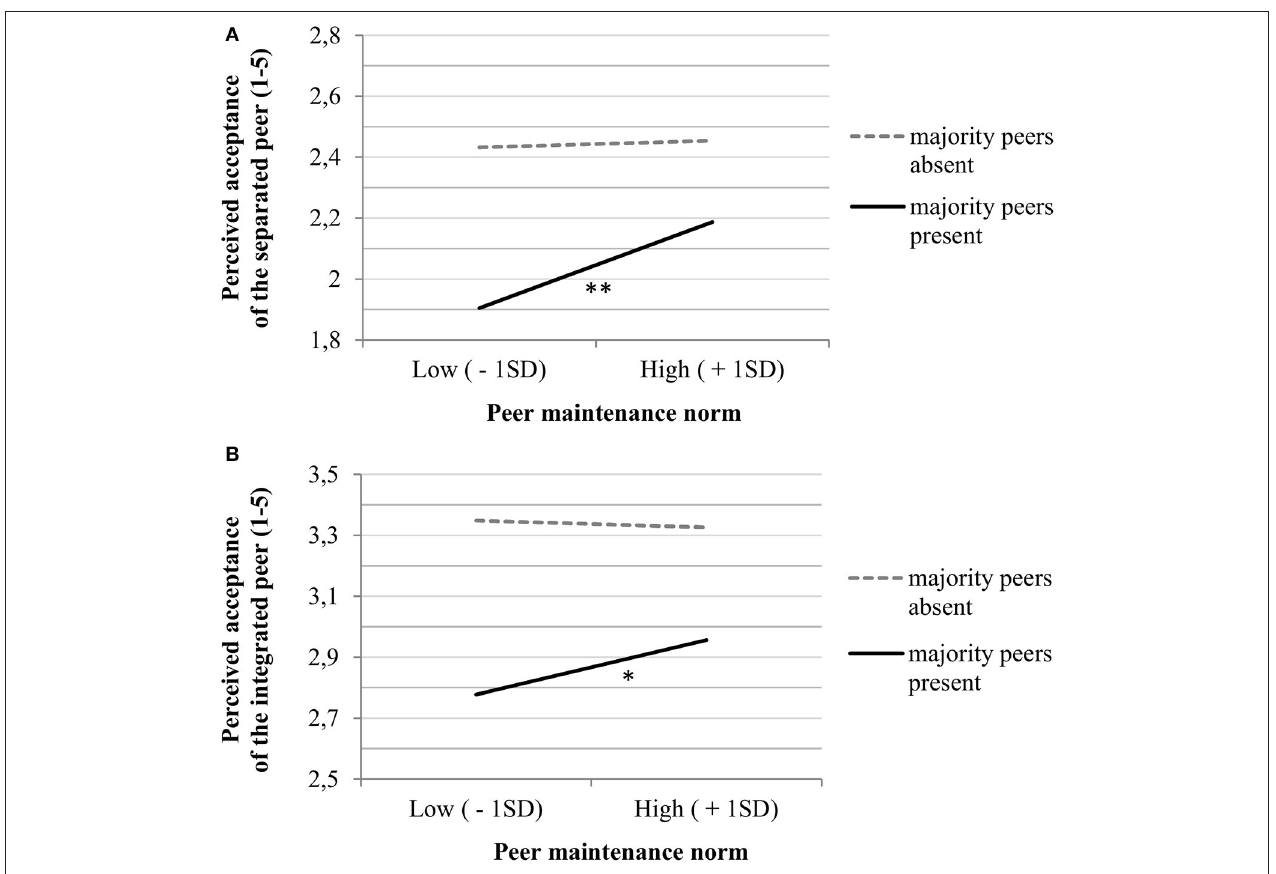
FIGURE 2 | (A) Perceived acceptance of the (imagined) separated peer as a function of peer maintenance norm (hign vs. low) and the (lack of) majority peer presence in class ** p < 0.01. (B) Perceived acceptance of the (imagined) intergrated peer as a function of peer maintenance norm (hign vs. low) and the (lack of) majority peer presence in class * p <